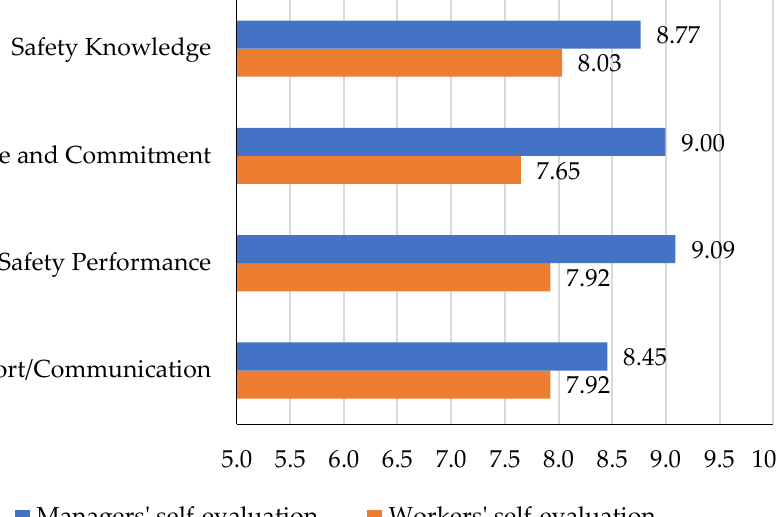
Figure 3. Comparing the self-evaluation of the two groups in four categories of safety perception.